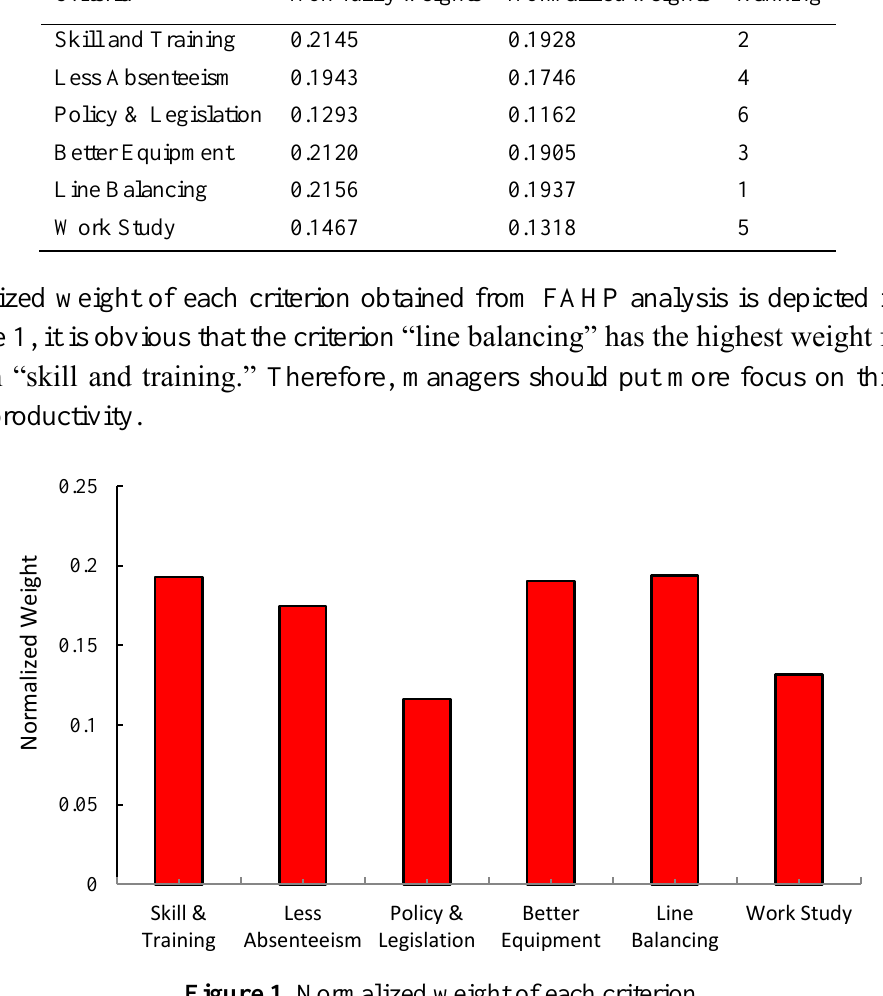
Figure 1. Normalized weight of each